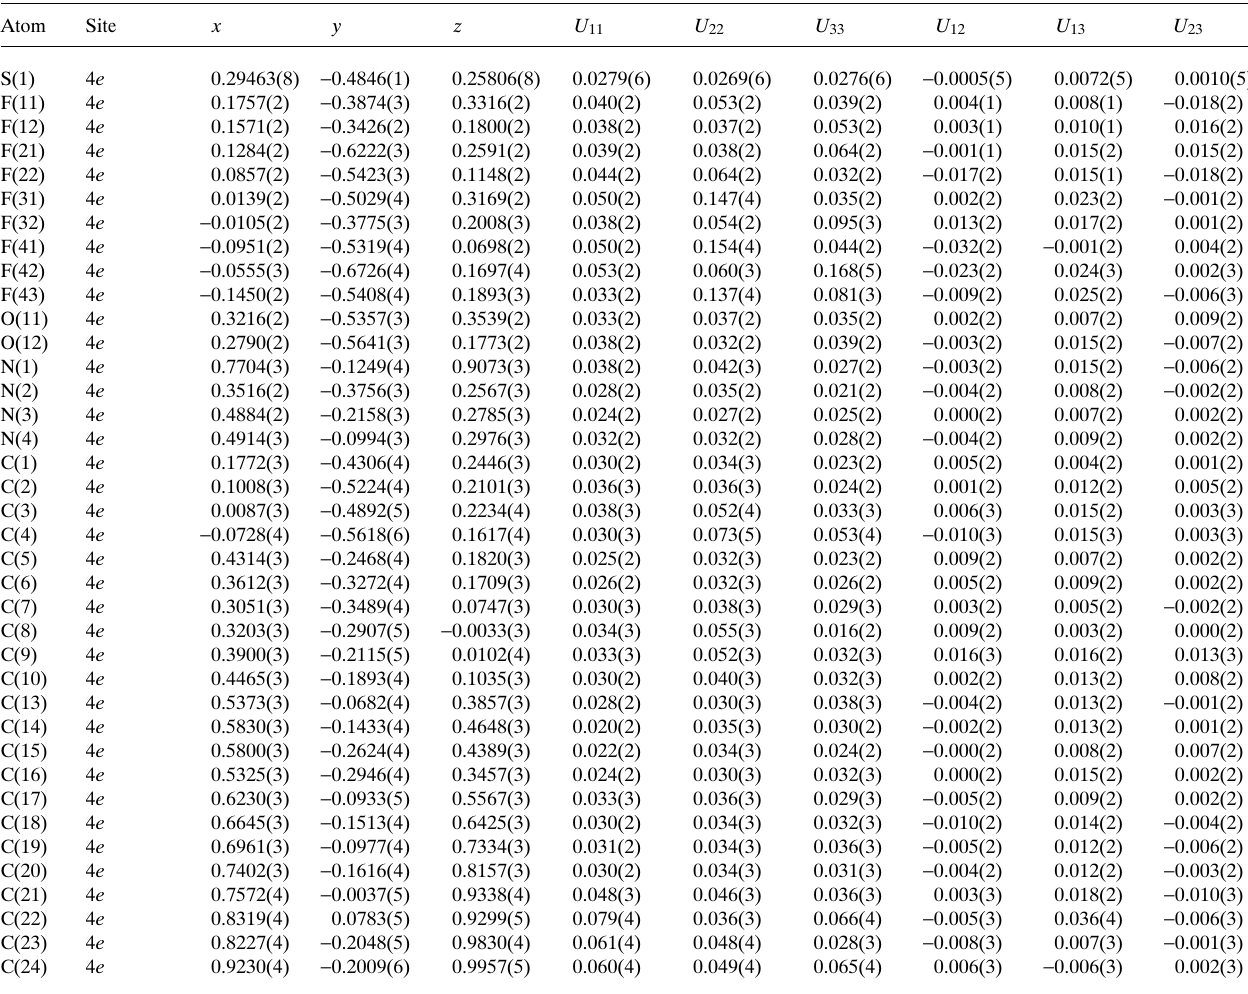
Table 3. Atomic coordinates and displacement parameters (in Å 2 )